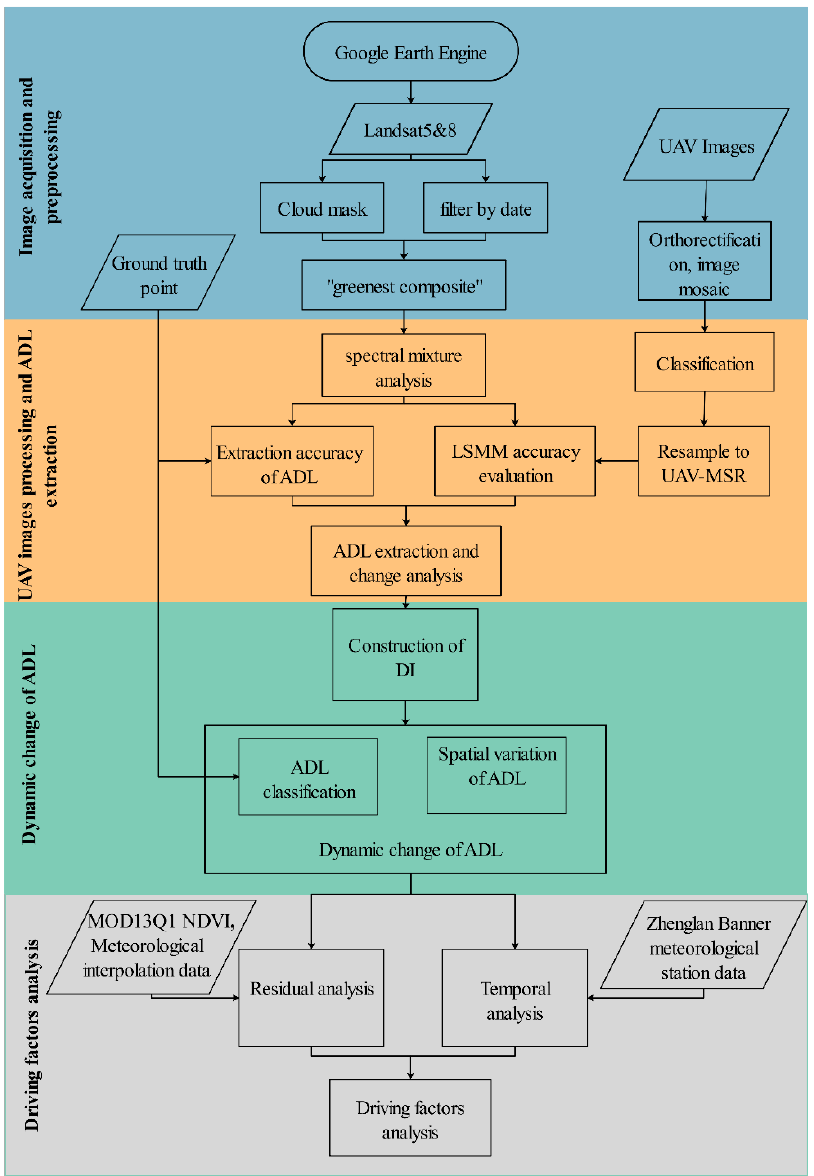
Figure 1. Research flow chart. The first part shows the preprocessing step of Landsat and UAV images. The second part shows the image processing steps to obtain the extent of the ADL. The third part shows the dynamic change evaluation of the ADL based on the desertification index (DI). The last part mainly focuses on the driving forces of aeolian desertification.